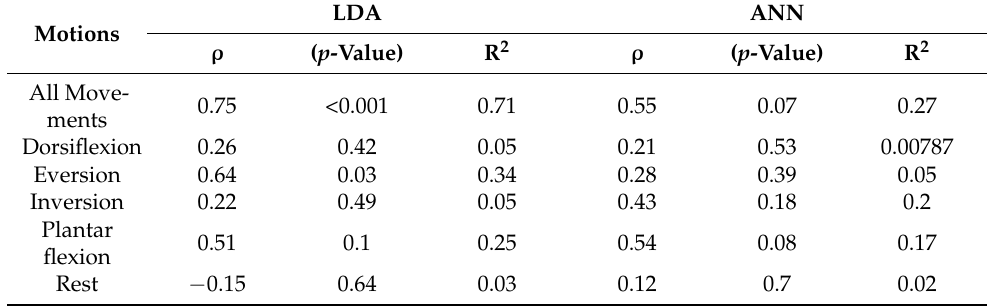
Table 2. Values of the Spearman correlation ( ρ ) and coefficient of determination (R 2 ) analysis between classification accuracies and movements (individual movement and average of all movements).